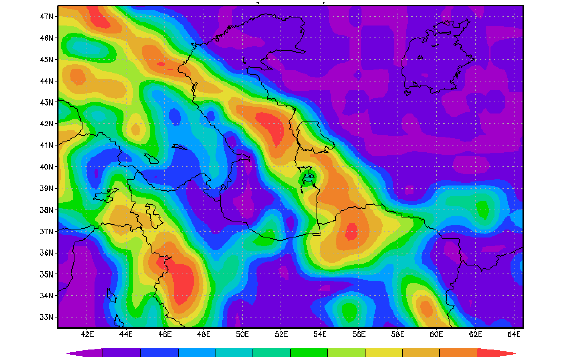
Figure 6. MODIS cloud fraction image for second of July 2014.